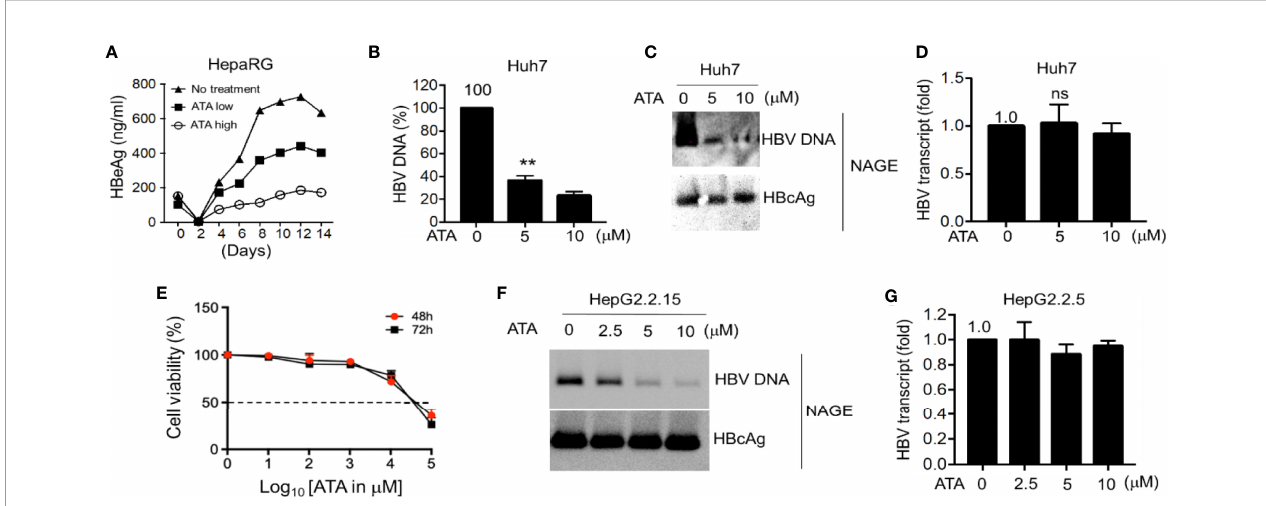
FIGURE 2 | ATA inhibits HBV replication in hepatocytes. (A) Differentiated HepaRG cells were infected with HBV virions for 14 days in the presence or absence of ATA at 5 (low) or 10 (high) m M, and viral production was measured by HBe ELISA at the time points as indicated. (B) Huh-7 cells were transfected with an HBV replicon plasmid (HBV1.5). At 24 h after transfection, cells were treated with or without ATA for 48 h, and HBV DNA was extracted from secreted HBV virions in the culture medium and measured by qPCR using HBV-speci fi c primers. (C) HBV nucleocapsids in cell lysates in (B) were estimated using the NAGE assay followed by Southern or Western blotting with HBV DNA probes or anti-HBc antibody (NAGE assay). (D) Total RNA in (B) was extracted, and RT-qPCR was performed to measure HBV transcripts. (E) Huh-7 cells (96-well plate format, 5 × 10 4 cells/well, triplicates) were treated with the indicated doses. Cell proliferation assays were performed at 48 and 72 h post-treatment. Dotted line indicates the 50% toxicity. Data are expressed as mean ± SD from three triplicates. (F) HBV nucleocapsids in HepG2.2.15 cells were estimated using the NAGE assay followed by Southern or Western blotting with HBV DNA probes or anti-HBc antibody. (G) Total RNA in (F) was extracted, and RT-qPCR was performed to measure HBV transcripts against GAPDH. ** p < 0.01; ns, not signi fi cant (two-tailed, unpaired Student ’ s t-test). Data are mean ± SEM of three independent experiments. All Western blotting data are representative of three independent experiments. ATA, aurintricarboxylic acid; HBV, hepatitis B virus; NAGE, native agarose gel